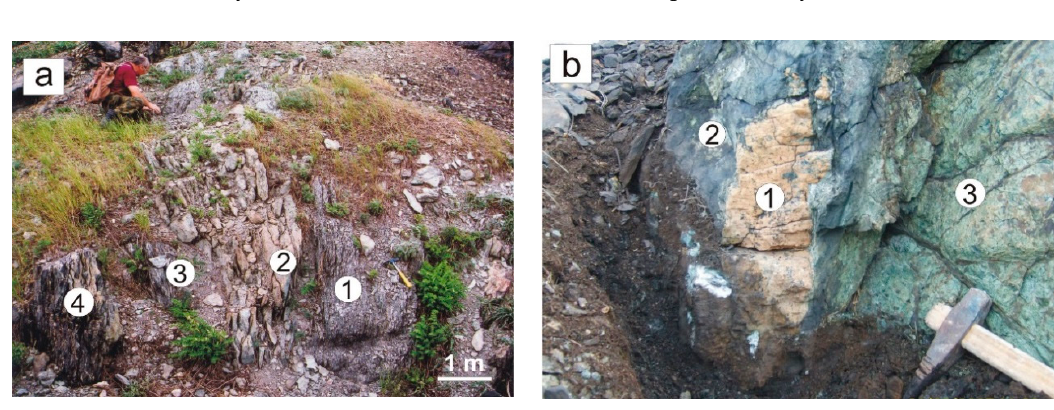
Figure 3. Zonation around ( a ) a large body and ( b ) a small lens of magnetite-chlorite-carbonate rocks. Zones: 1—magnetite-chlorite-dolomite, 2—chloritolite, 3—serpentinite with carbonatization and chloritization, 4—antigorite serpentinite. (a) The central zone (2) is composed of nearly equal amounts of carbonate and magnetite and a minor amount of chlorite, the content of which increases in the marginal parts of the zone. (b) The central zone (1) is composed of dolomite and a small amount of chlorite.